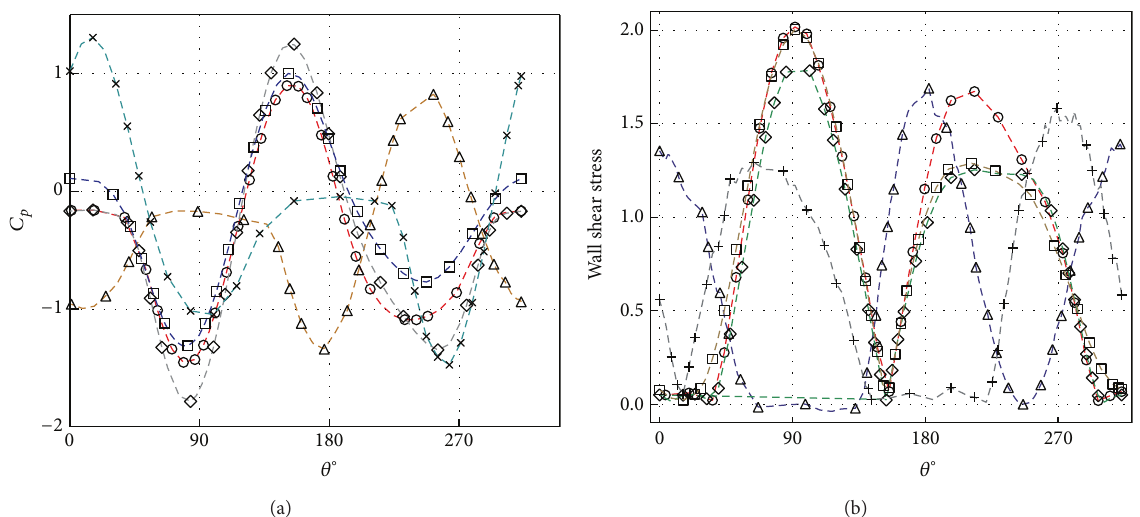
Figure 9: Effect on (a) pressure coefficient (𝐶 𝑝 ) and (b) wall shear stress at cylinder surface of different scour gaps, I 10min, △ 30min, ⬦ 100min, ◻ 200min, and × 300 min.